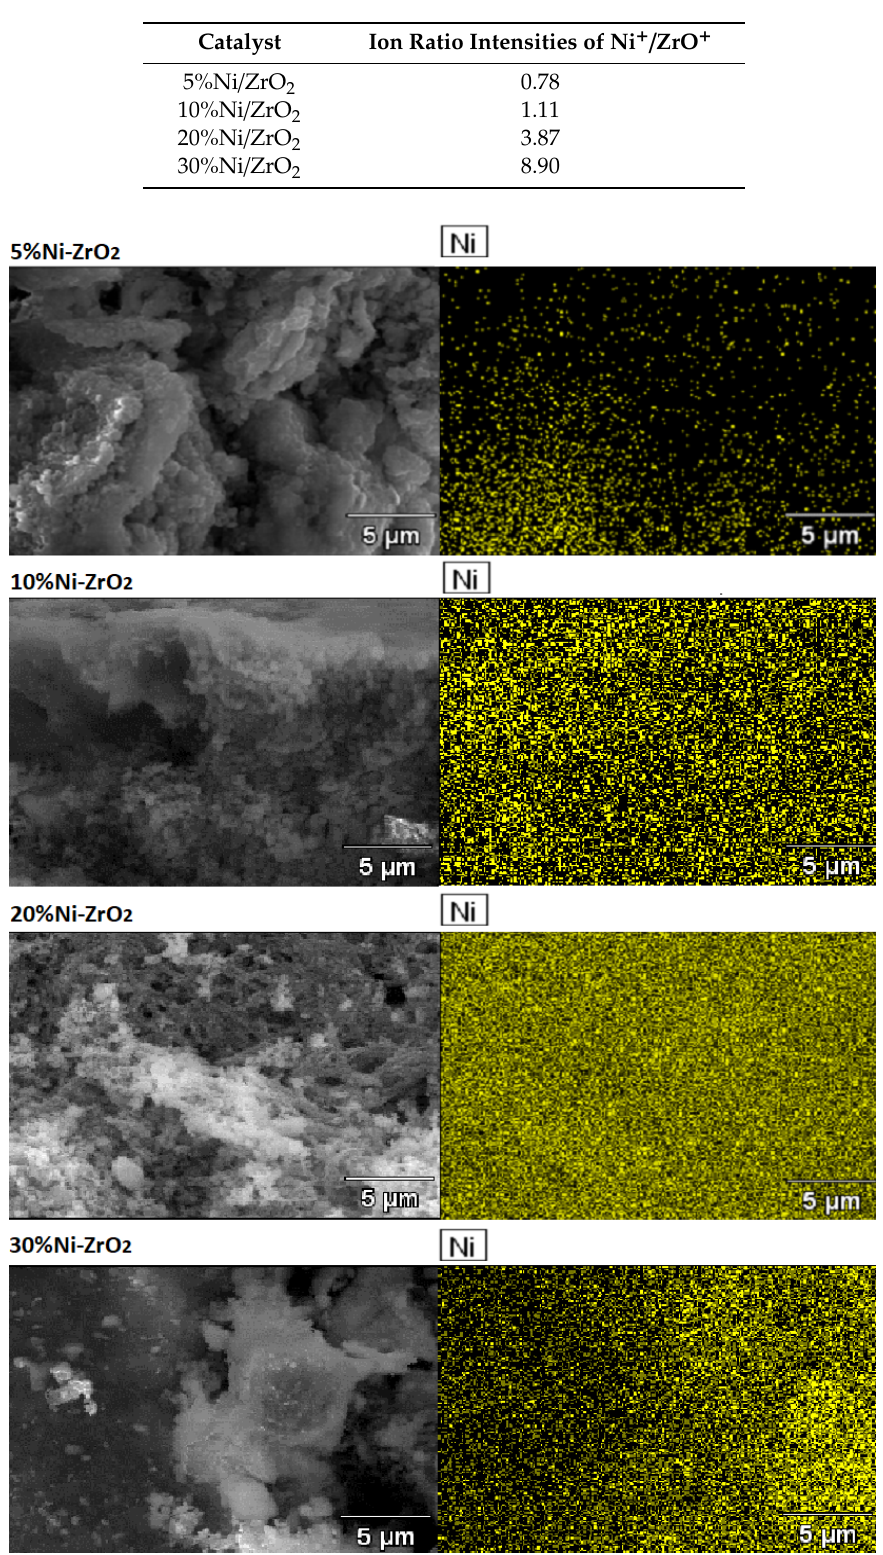
Figure 19. Measurements for monometallic Ni catalysts supported on ZrO 2 oxide calcined at 400 ◦ C in an air atmosphere for 4